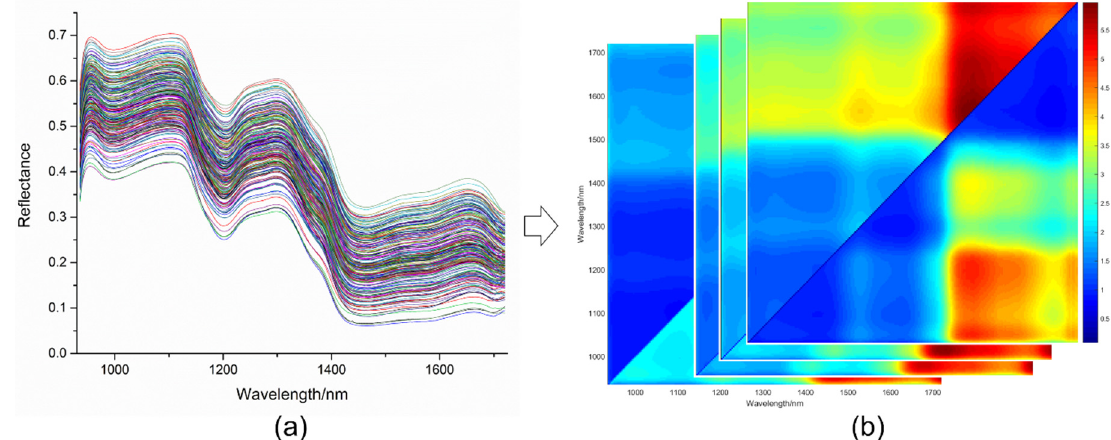
Figure 7. Transformation from the original average spectra ( a ) to 2D matrices ( b ). Table 3. Performance of VGG net models established by 2D spectral matrices.